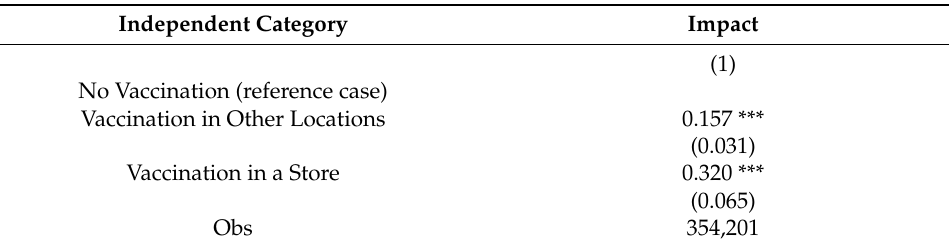
Table A2. Multinomial logit model of the impact of explicit vaccination authority for pharmacists on likelihood of receiving influenza vaccine by location.